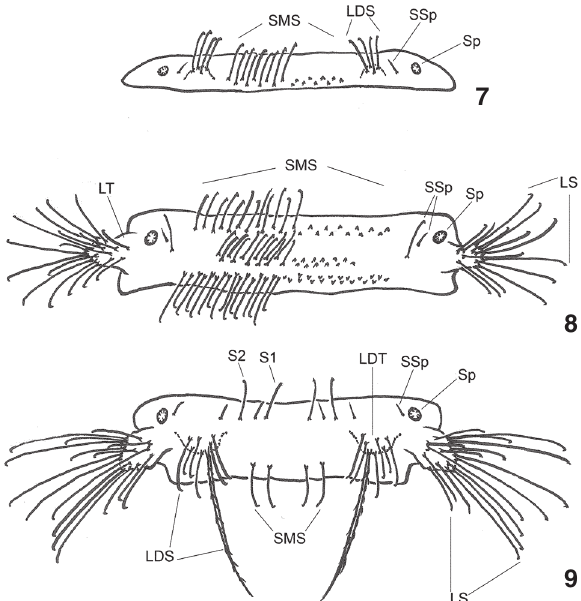
Figuras 7-9. Abdome do terceiro instar de C. caligata , vista dorsal: (7) primeiro segmento abdominal; (8) segundo segmento abdo- minal; (9) sexto segmento abdominal. (LDS) cerda no tubérculo látero-dorsal, (LDT) tubérculo látero-dorsal, (LS) cerda no tubér- culo lateral, (LT) tubérculo lateral, (SMS) cerda submediana, (Sp) espiráculo, (SSp) cerda associada ao espiráculo, (Sx)